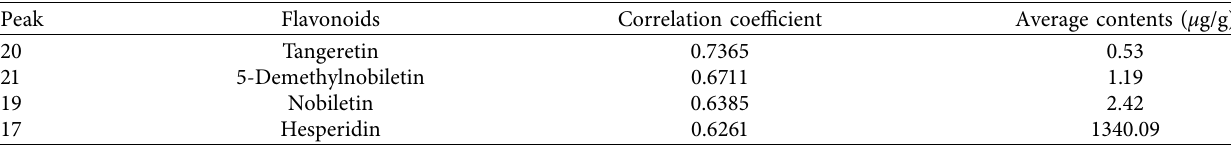
Table 12: Te results of dose-efect correlation